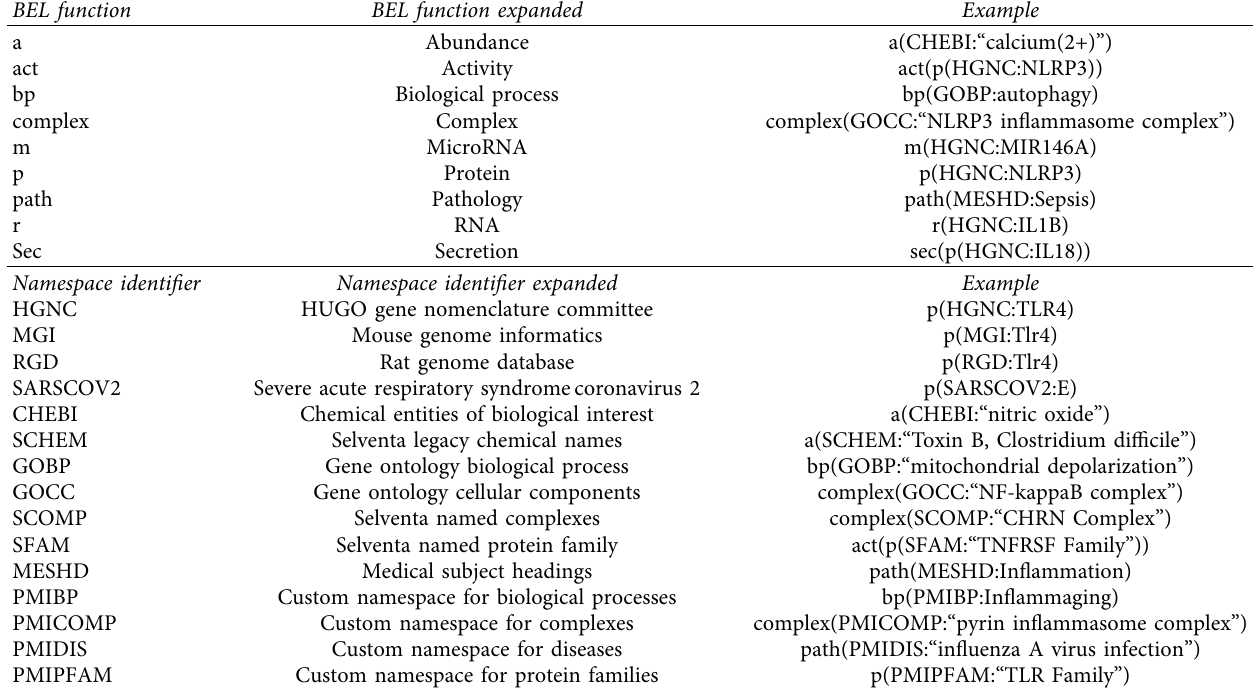
Table 1: BEL vocabulary for the namespaces used in the inflammasome CBN model. BEL